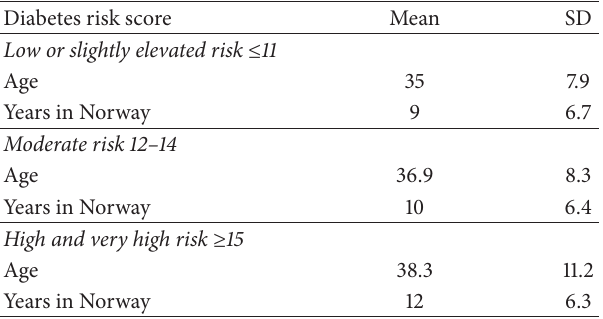
Table 2: Diabetes risk by age and years of stay in